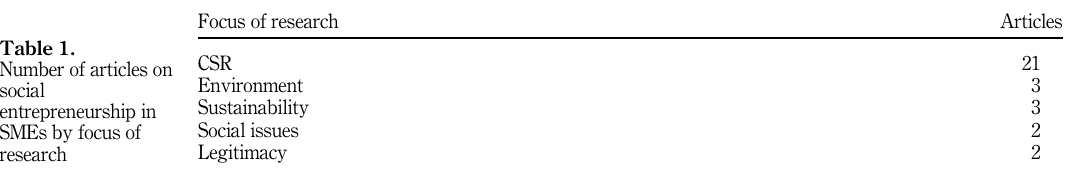
Table 1. Number of articles on social entrepreneurship in SMEs by focus of research